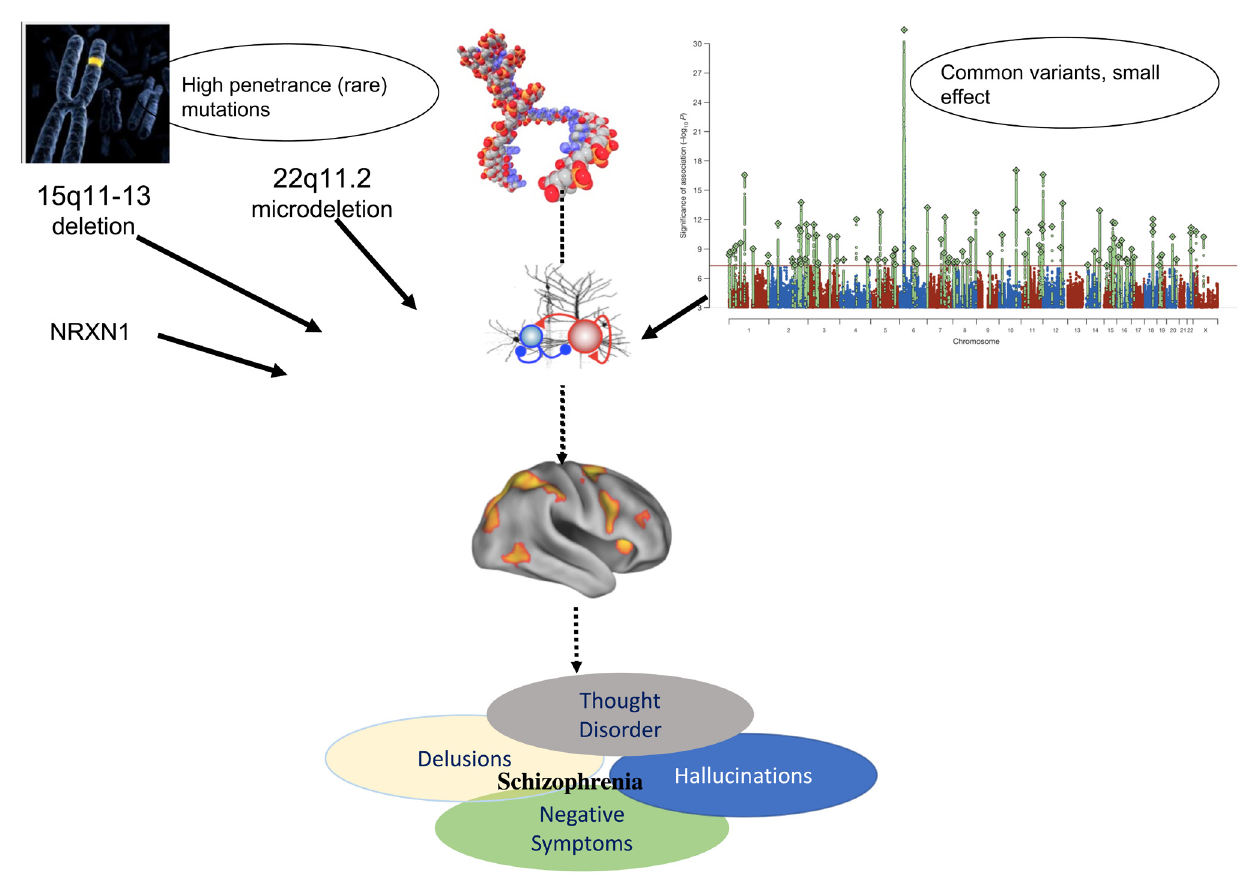
Figure 1. Convergence of rare and common genetic variation on disrupted synaptic function and neurodevelopmental processes. Top right-hand panel reprinted by permission from: Springer Nature. Nature . Biological insights from 108 schizophrenia-associated genetic loci. Schizophrenia Working Group of the Psychiatric Genomics Consortium, Stephan Ripke, Benjamin M. Neale, Aiden Corvin, James T. R. Walters et al. ,